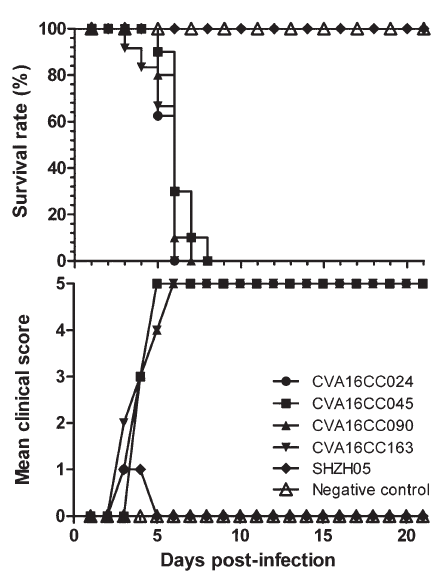
Figure 2. Clinical scores and survival of neonatal mice infected with circulating Coxsackievirus A16 (CVA16) Changchun (CC) strains CC024, CC045, CC090, or CC163, or the noncirculating CVA16 SHZH05 strain. Neonatal mice (n=8-10 per litter) were intracerebrally infected with 20 m L of 10 5.5 CCID 50 /mL of each of the CVA16 virus strains, or mock infected with DMEM. The mean clinical scores and survival rates were monitored and recorded daily for 21 days postinfection.